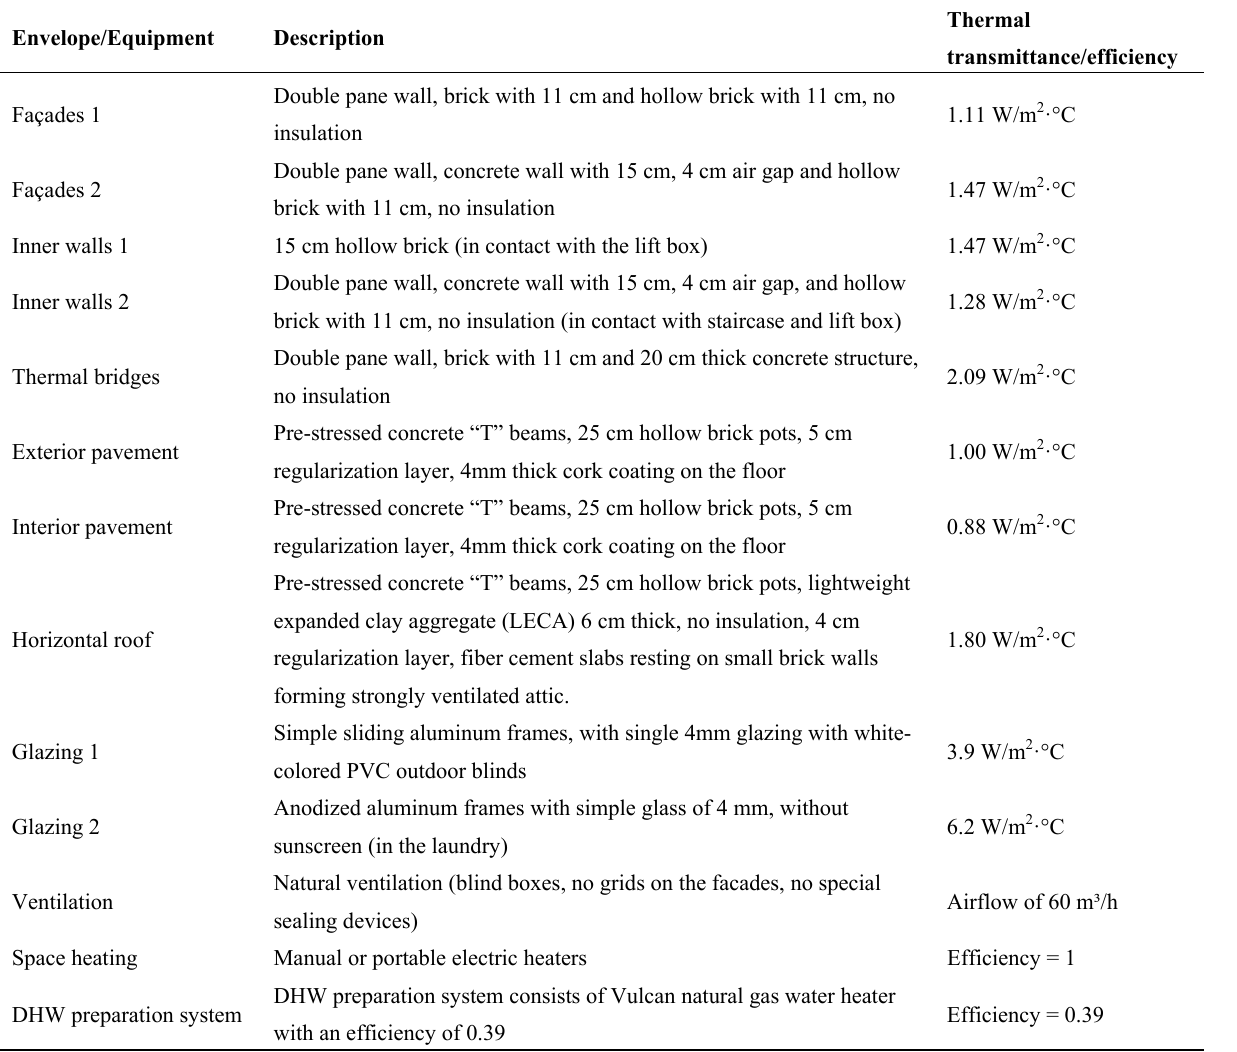
Table 2. Description of the housing envelope and equipment—Azenha de